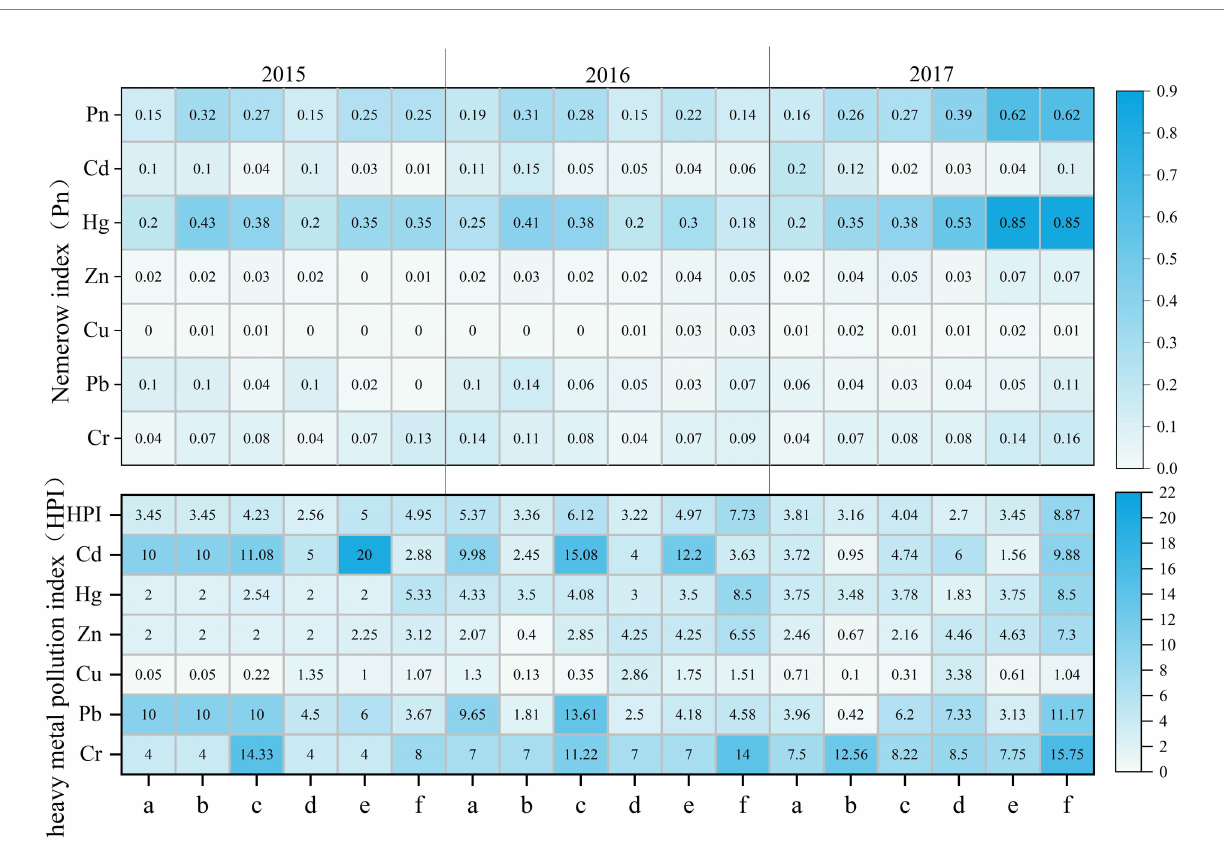
FIGURE 8 Inter-annual variation of the Nemerow pollution index ( P n ) and heavy metal pollution index (HPI) in the Hanjiang River from 2015 to 2017 (Note: a = sites SW and XR, b = sites BJ and YJ, c = sites GA, ZD, and HZ, d = sites GS, ZK, and YK, e = sites HN and SL, f = sites LH, XG, ZG, and